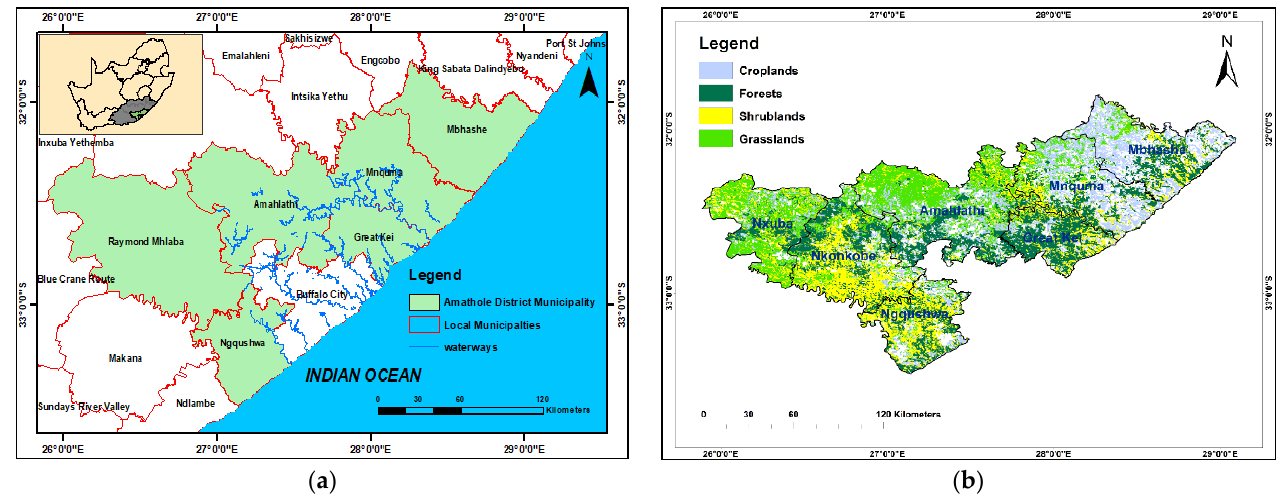
Figure 1. Map showing the local municipalities ( a ) and the distribution of dominant land cover types ( b ) in Amathole District Municipalities, Eastern Cape Province, South Africa.